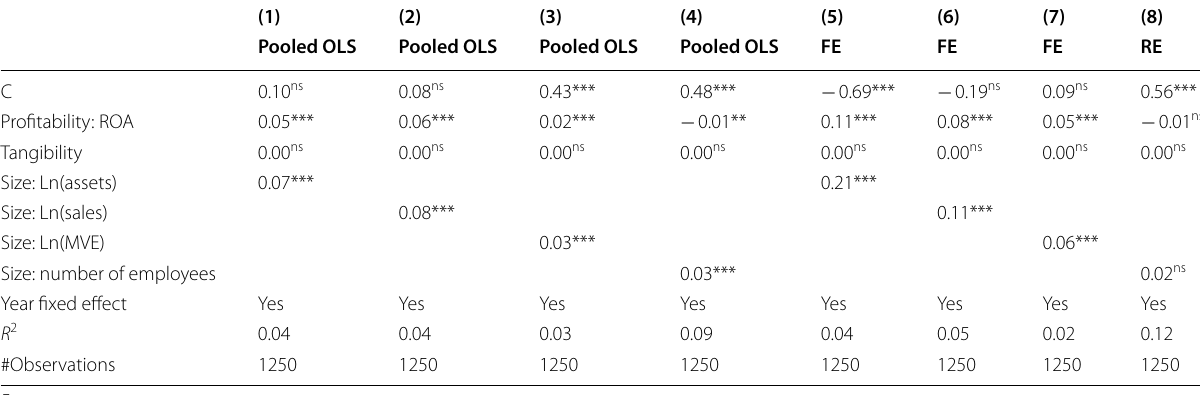
Table 5 Regression analysis of firm size (total asset, total sales, MVE and number of employees) and financial leverage (debt to equity)